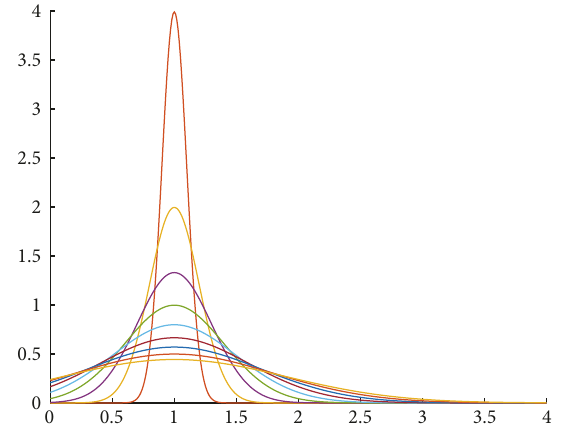
Figure 10: Error factors for the inaccuracy of the measured